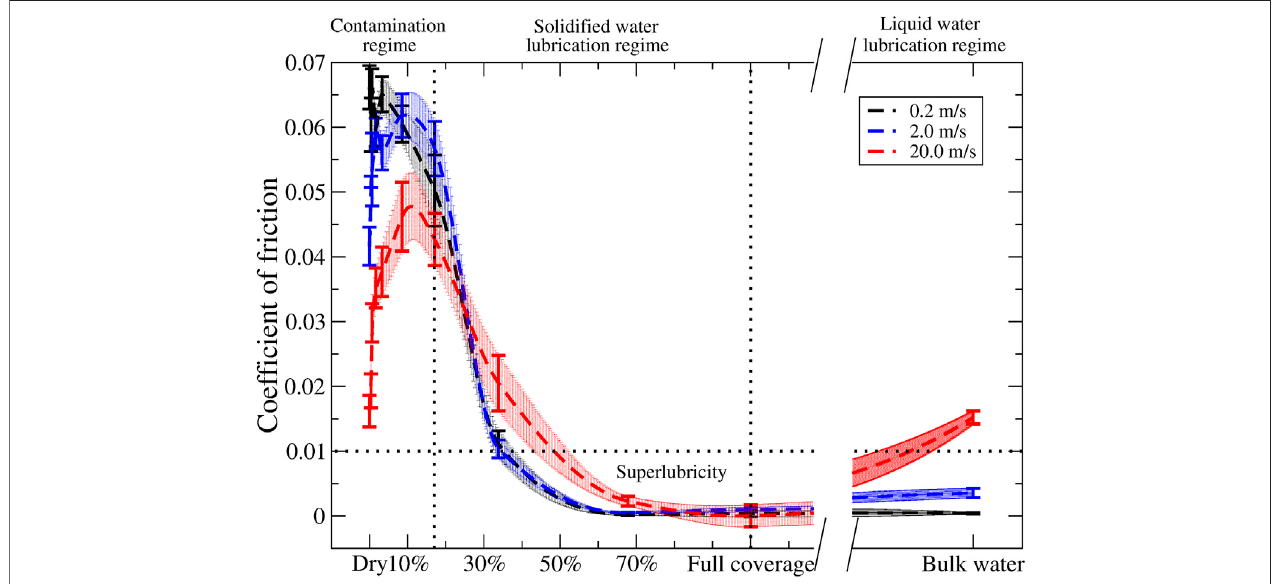
FIGURE6| Coef fi cientsoffrictionfordifferentslidingvelocities,0.2(black),2.0(blue),and20.0(red)m/s,plottedvs.watercoverage.Thedashedlinesandthearea around itresult from akima interpolation and serve asaguide to theeyes.The error bars result from the linear fi ttaking into accountthe errors obtained via the bootstrap